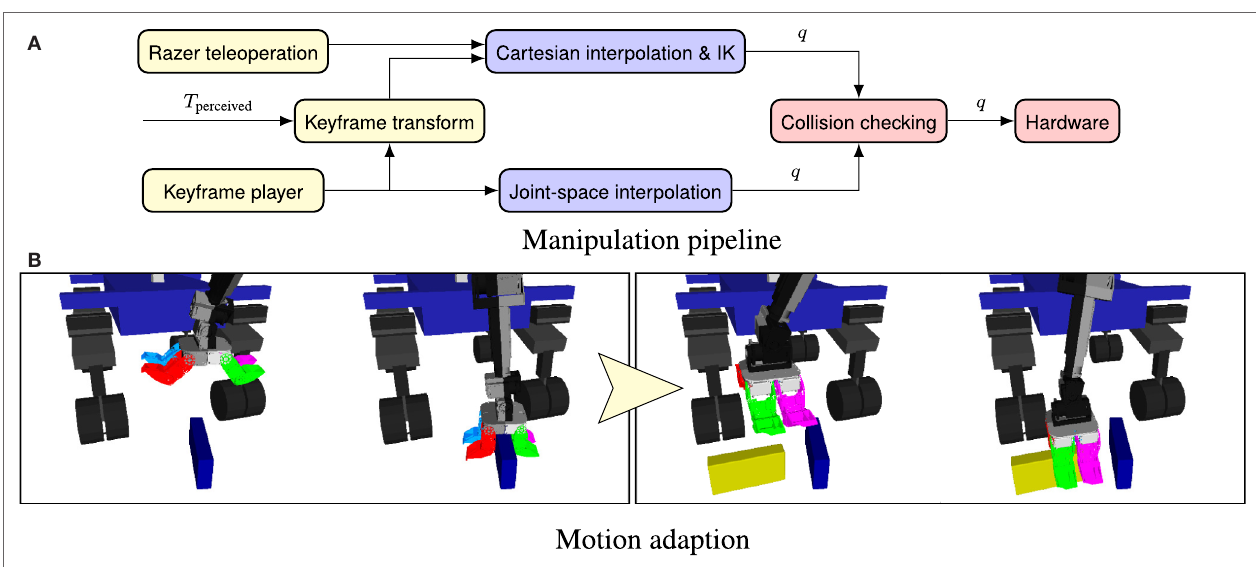
FIGURE 9 | Object manipulation . (A) Kinematic control architecture for Momaro. Joint configurations can be generated using magnetic trackers or the keyframe player. Cartesian poses in keyframes can be adapted to a measured pose p . The interpolated configurations T perceived are checked for collisions before they are sent to the hardware. (B) Grasping objects dynamically using motion adaption. Left: the blue reference object is grasped as the primitive was designed in the Keyframe editor. Right: the primitive is automatically adapted to the perceived pose of the yellow